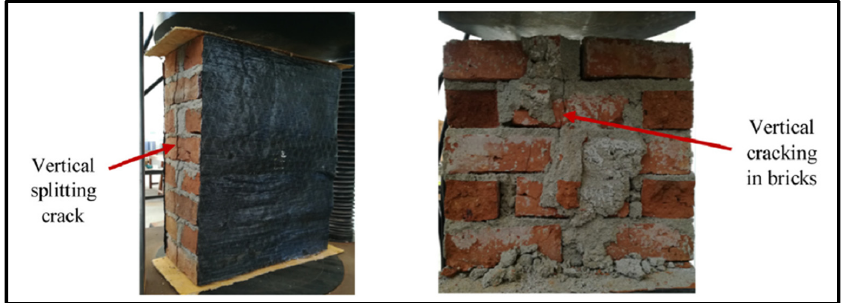
surface is shown in Figure 13b. is shown in Figure 13b. is shown in Figure 13b.